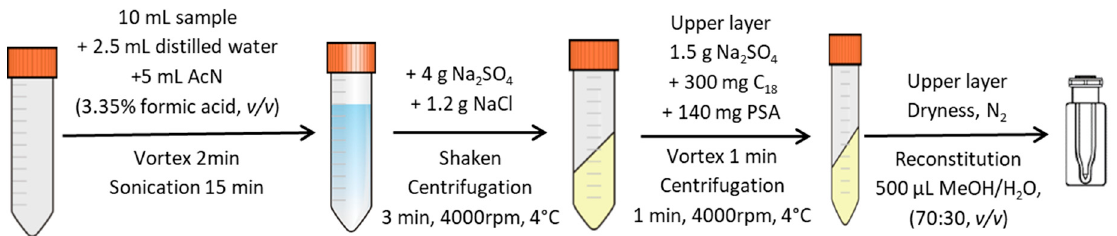
Figure 1. Schematic flow of the sample preparation procedure.